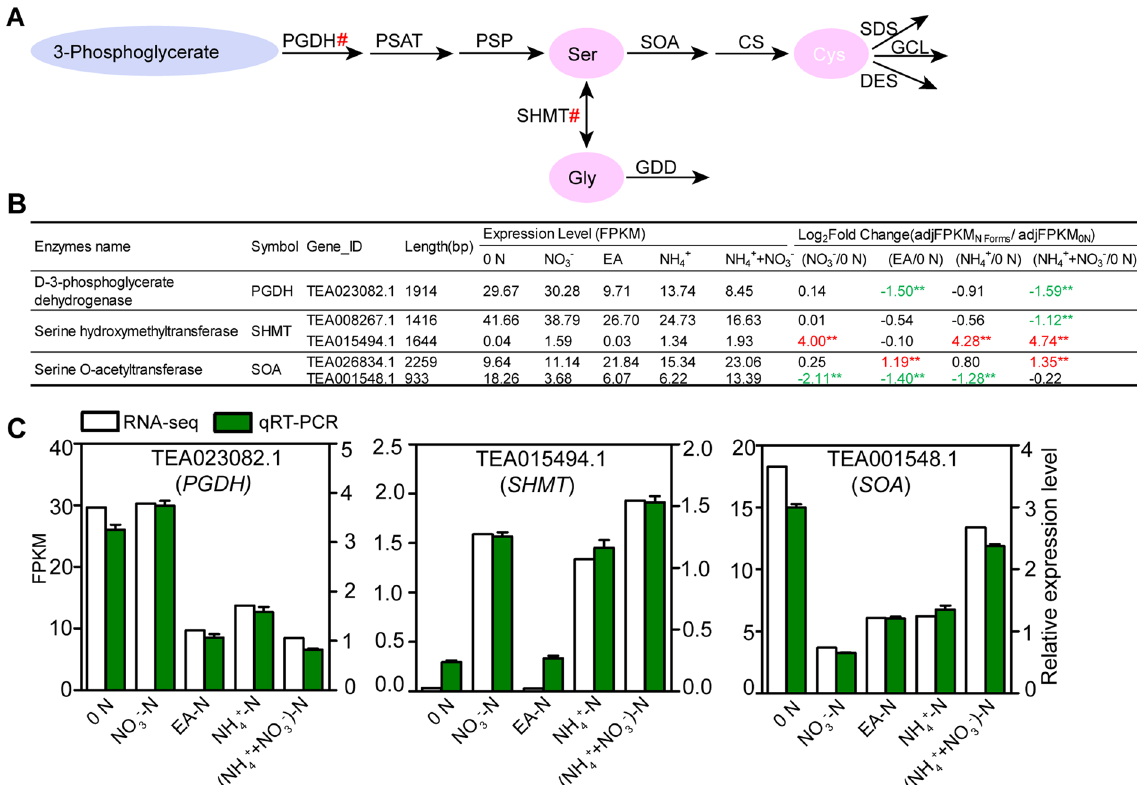
Figure 8. Identification of DEGs encoding enzymes related to 3-phosphoglycerate pathway. ( A ) The DEGs encoding enzymes related to synthesis and first step degradation pathway of amino acids from 3-phosphoglycerate pathway. ( B ) The expression levels and relative fold change (log 2 [ adj FPKM N forms / adj FPKM 0 N ]) of DEGs related to amino acids from 3-phosphoglycerate pathway. The table indicates genes with significant changes (fold change ≥ 2, p < 0.05; marked by two asterisks and number in red or green) in 0 N versus different forms of N. 0 N, N free; NO 3 − , NO 3 − -N, EA, Ethylamine-N; NH 4 + , NH 4 + -N; (NH 4 ++ NO 3 − ), (NH 4 + + NO 3 − )-N. ( C ) Quantitative real-time PCR validation for potential candidate genes. The relative expression levels and FPKM values are